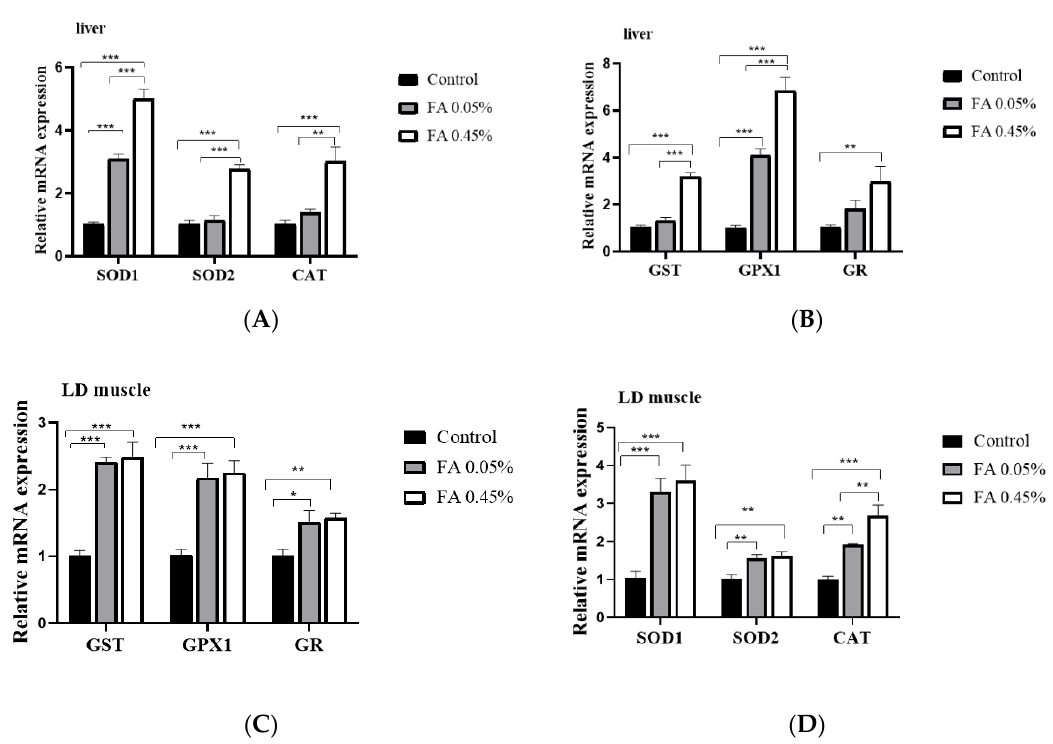
Figure 1. Effect of dietary FA supplementation on the expression of antioxidant enzyme genes in weaned piglets. ( A , B ) The mRNA abundance of SOD1 , SOD2 , CAT , GST , GPX1 , and GR in LD muscle. ( C , D ) The mRNA abundance of SOD1 , SOD2 , CAT , GST , GPX1, and GR in liver. The mRNA level of target genes was normalized to the amount of GAPDH mRNA. Data were the mean and standard errors ( n = 6). * p < 0.05, ** p < 0.01, and *** p < 0.001. FA : Ferulic acid, LD : Longissimus dorsi , SOD1: